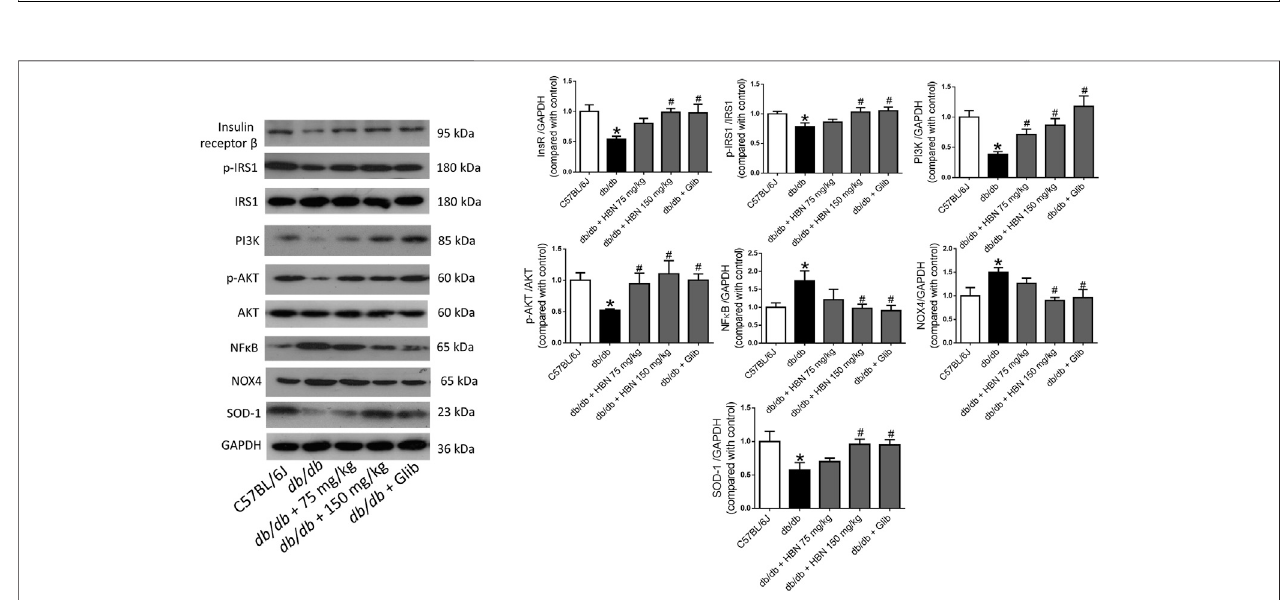
FIGURE 6 | Effects of HBN on adipose insulin signaling, in fl ammation and oxidative stress. Western blot and quantitative data showing the protein expression in adipose tissue of C57BJ/L6 mice and db/db mice after treatment with HBN (75 and 150 mg/kg) and glibenclamide (1 mg/kg). Results are mean ± SEM of six experiments. * p < 0.05 compared to C57BL/6J mice, # p < 0.05 compared to db/db